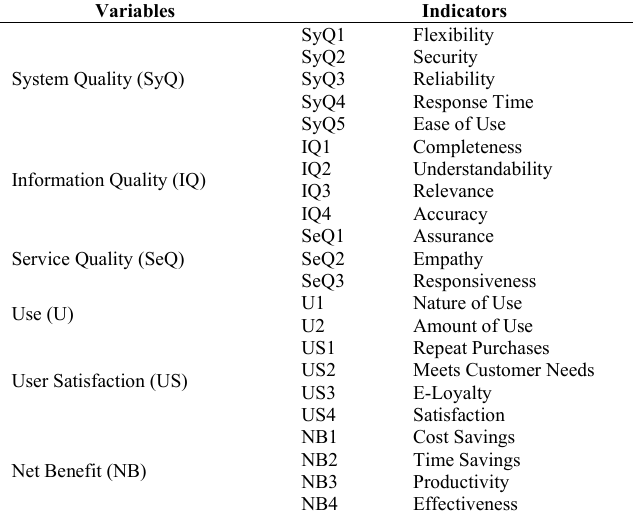
TABLE 1 VARIABLES AND INDICATORS OF THIS